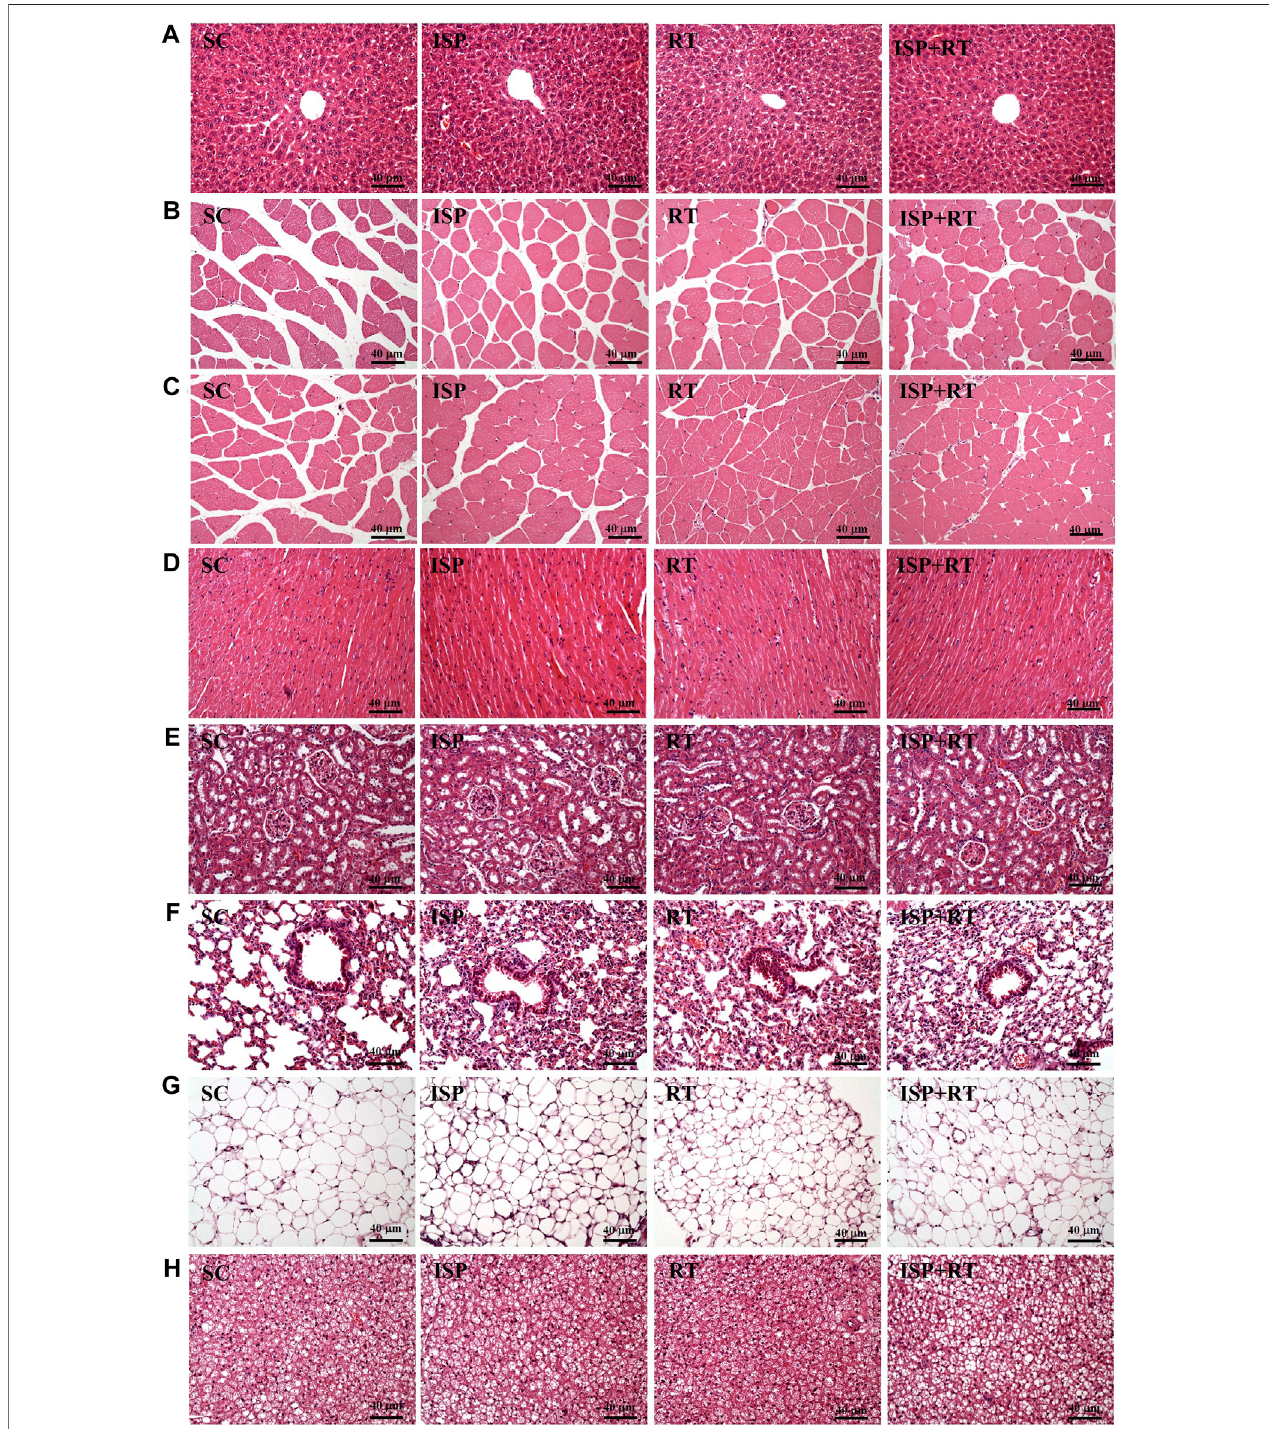
FIGURE 6 | Effect of ISP supplementation and RT of aging mice on (A) liver, (B) thigh muscle, (C) muscles, (D) heart, (E) kidney, (F) lung, (G) OFP, and (H) BAT tissue in mice (H&E stain, magni fi cation: ×200; bar, 40 μ m; BAT magni fi cation: ×100; bar, 80 μ m).